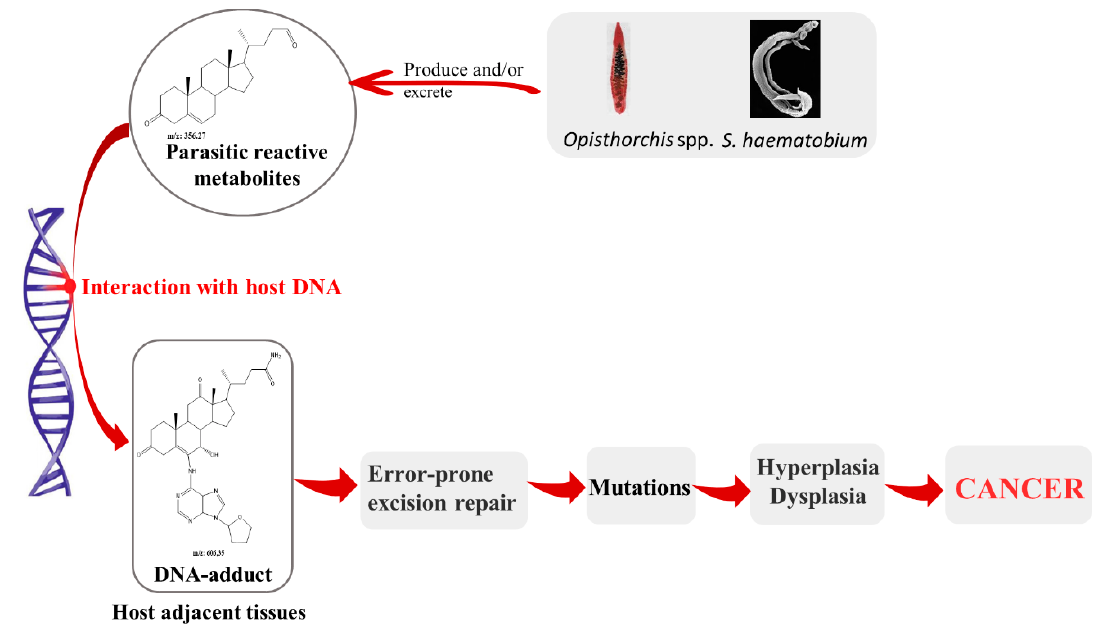
Figure 2. Carcinogenesis mediated by reactive metabolites of S. haematobium and O. viverrini . Reactive metabolites of parasite origin likely interact with host DNA inducing DNA apurinic sites that may escape the DNA repair mechanisms leading to mutations. These mutations may ultimately transform the target cell, leading to dysplasia and malignant neoplasia.